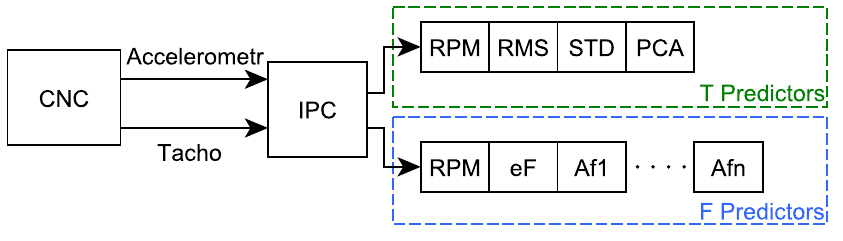
Figure 6. Scheme of predictors calculation using IPC (“eF”—Spectrum energy, “Af1” to “Afn”—the sequence of amplitudes of individual spectral